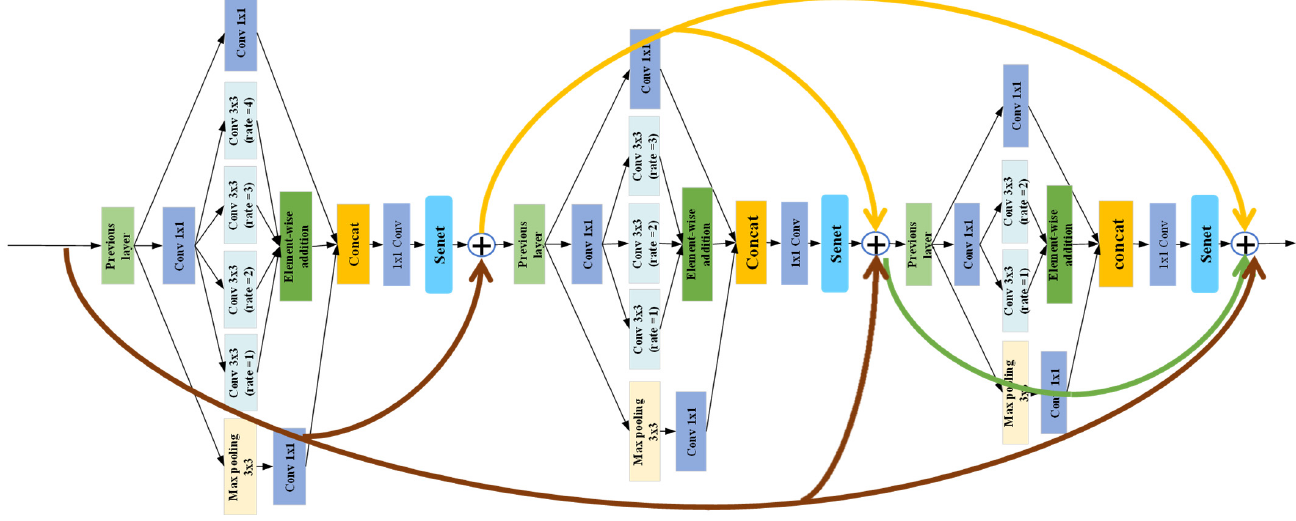
Figure 9. The overview of the cascade dense connectivity